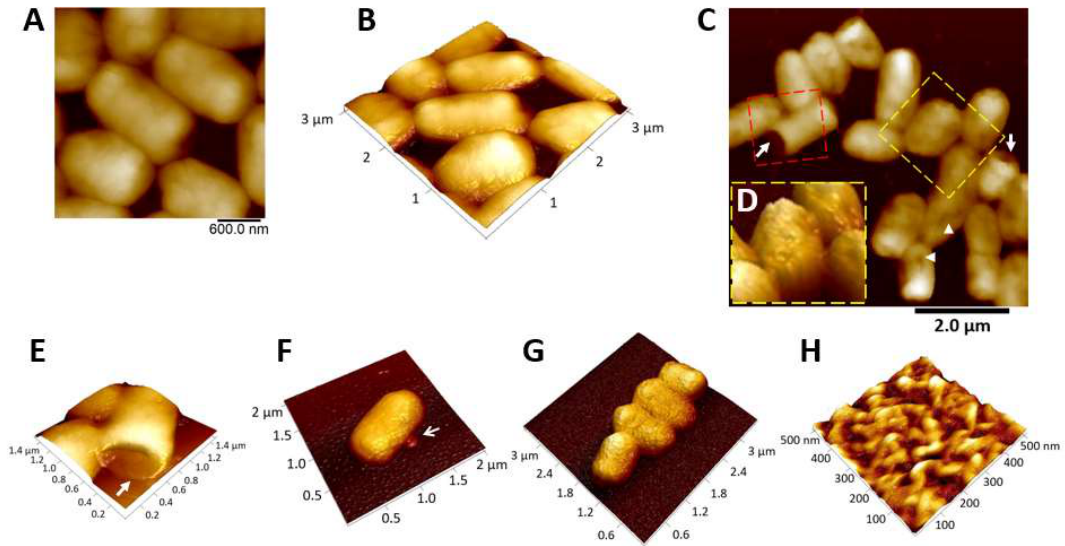
Figure 4. The effects of mastoparan-AF on hemolytic E. coli O157:H7 investigated by SEM. ( A ) Un- treated hemolytic E. coli O157:H7. ( B ) Hemolytic E. coli O157:H7 were treated with mastoparan-AF at 2 × MIC (32 μg mL −1 ) for 1 h. Abnormal dents and large perforations (full opening) at apical ends (indicated by arrows) appeared on the surface of bacteria.